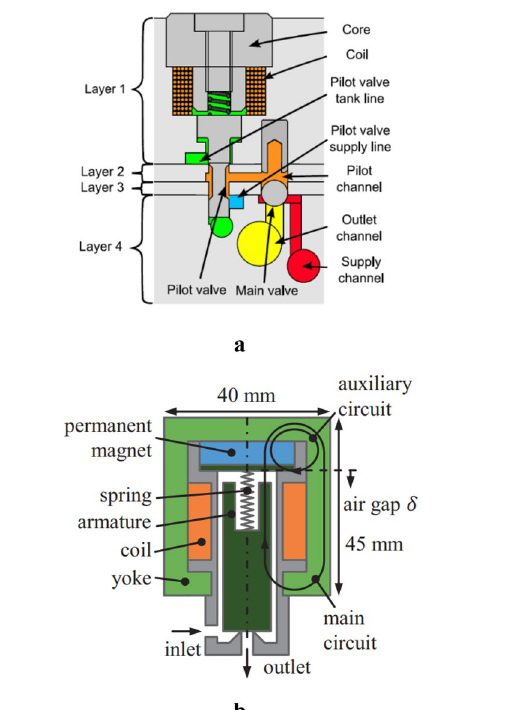
Figure 11 Spools: ( a ) traditional; ( b ) separate orifices; Housings: ( c ) traditional; ( d ) separate orifices Figure 12 ( a ) A miniature switching valve with the pilot stage; ( b ) Bi-stable latching